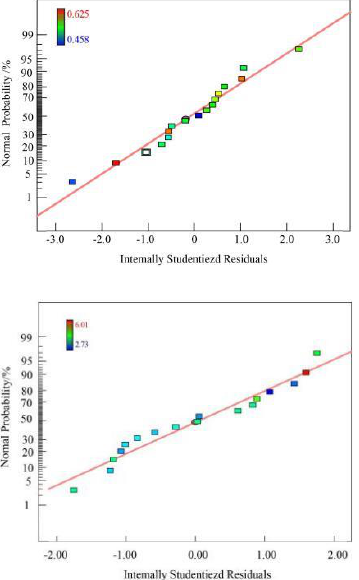
Figure 12. Normal distribution of residuals.